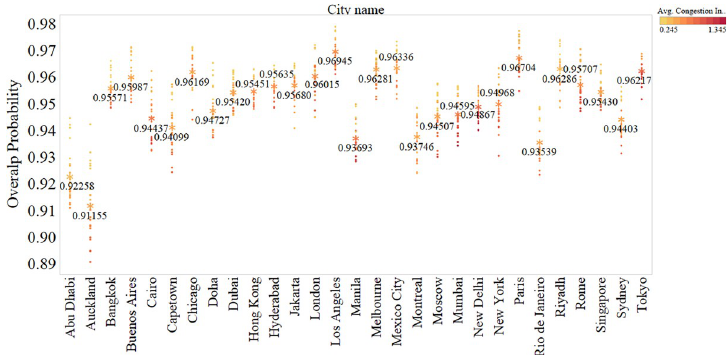
Fig 9. Stability of network equilibrium. Estimated overlap probability at every one hour for each city. The average estimated overlap probability values are highlighted and marked.